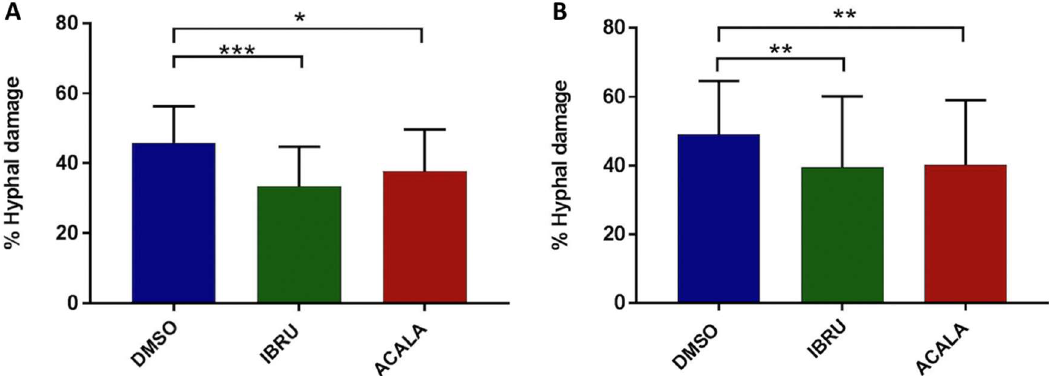
Figure 4. In vitro effects of ibrutinib and acalabrutinib on platelet-mediated hyphal damage. Platelet-rich plasma (PRP) from healthy volunteers ( A ) and treatment-naïve CLL patients ( B ) was treated with 1 µM ibrutinib (IBRU), acalabrutinib (ACALA), or vehicle (DMSO) for 1 h at 37 °C. A. fumigatus conidia were incubated for 16 h at 37 °C in RPMI medium plus 1% sodium pyruvate to produce hyphae with or without platelets, at an effector-to-target (E:T) ratio of 100:1. For measurement of hyphal metabolic activity, XTT salt plus 40 µg/mL coenzyme Q was added. Absorbance was determined at 450 nm using an enzyme-linked immunosorbent assay plate reader, and antifungal activity was calculated as the percentage of hyphal damage equal to [1 − (X/C)] × 100, where X is the optical density of test well and C is the optical density of control wells with hyphae only (* p < 0.05; ** p < 0.01; *** p < 0.001).